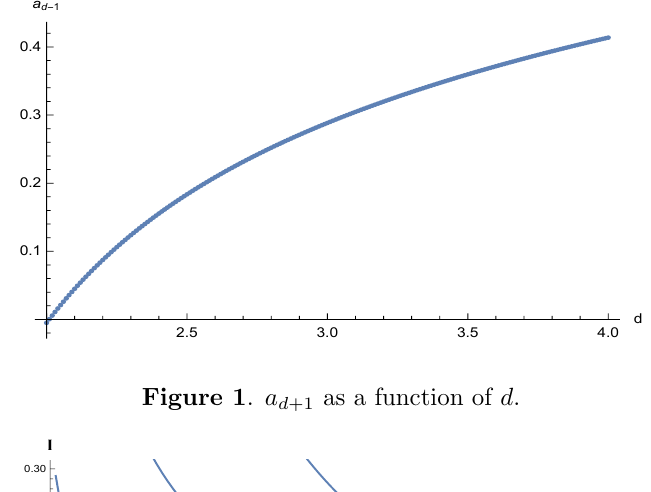
Figure 1 . a d +1 as a function of d .